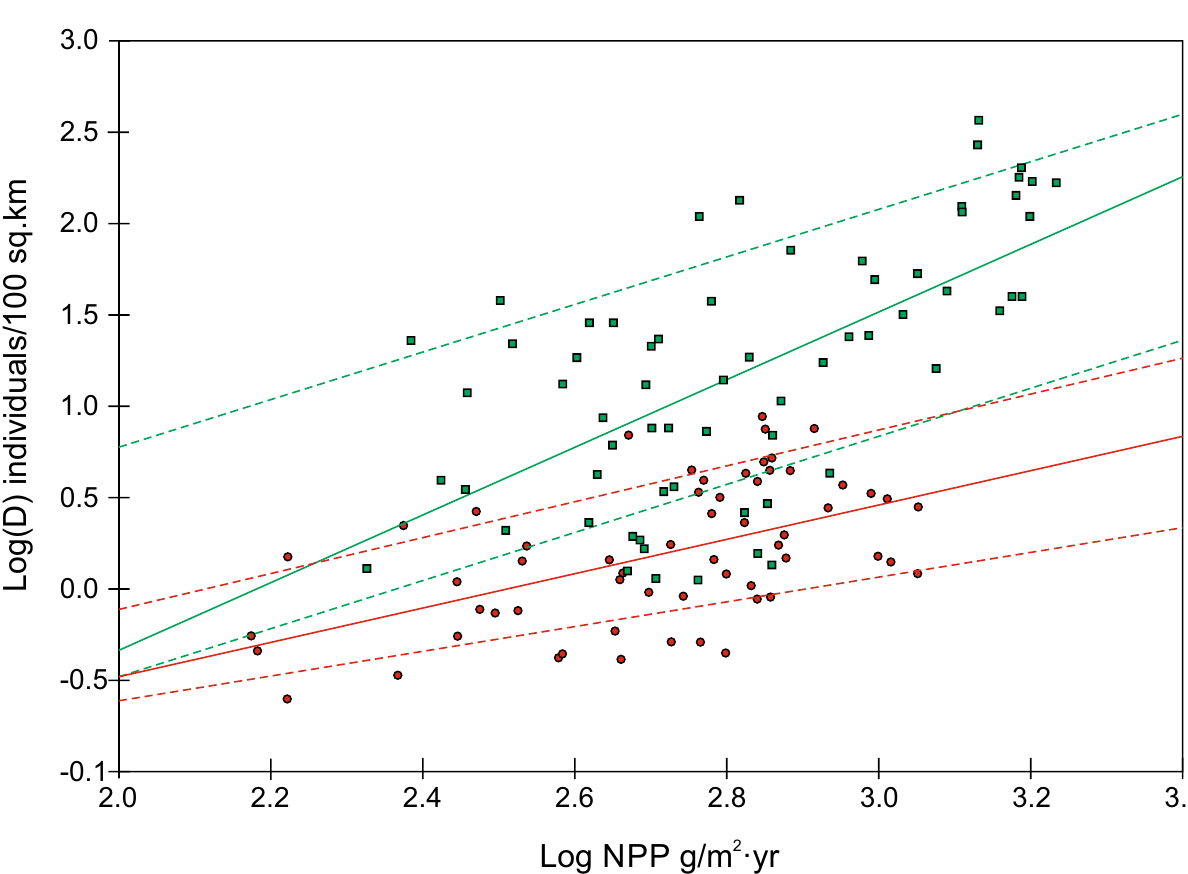
Figure 2. Relationship between net primary production (NPP) and hunter-gatherer population density (D). Green squares represent groups classified as ‘gatherers’ and red circles correspond to ‘hunters’. The solid lines are the regression equations fitted to the total sample of ‘gatherers’ (green) and the total sample of ‘hunters’ (red). Dashed lines are the regression equations to the upper and lower limit of the distribution of ‘gatherers’ (green) and ‘hunters’ (red),